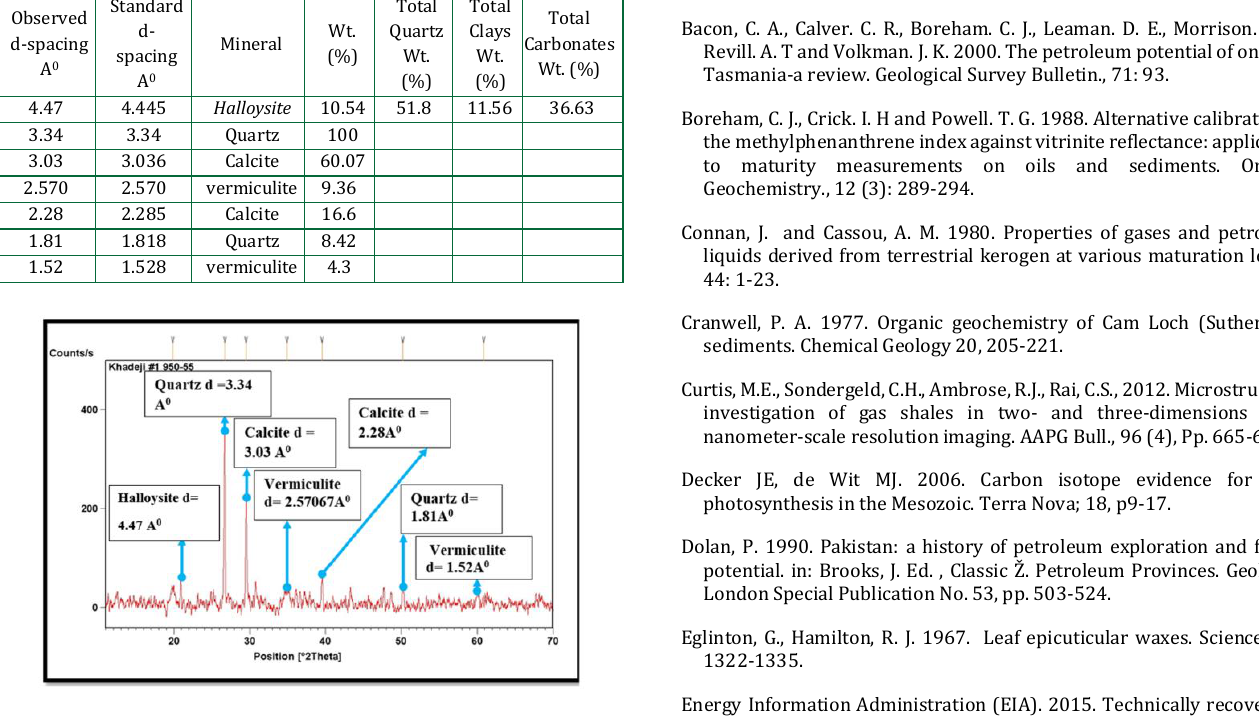
Figure 11: Showing powder x-ray diffraction pattern of Laki Formation shale in Khadeji well.